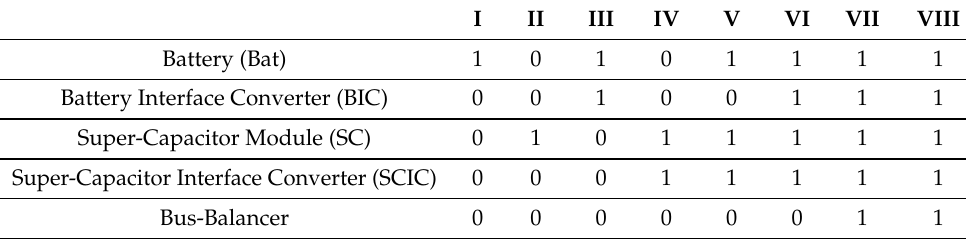
Table 7. Sub-systems of the different